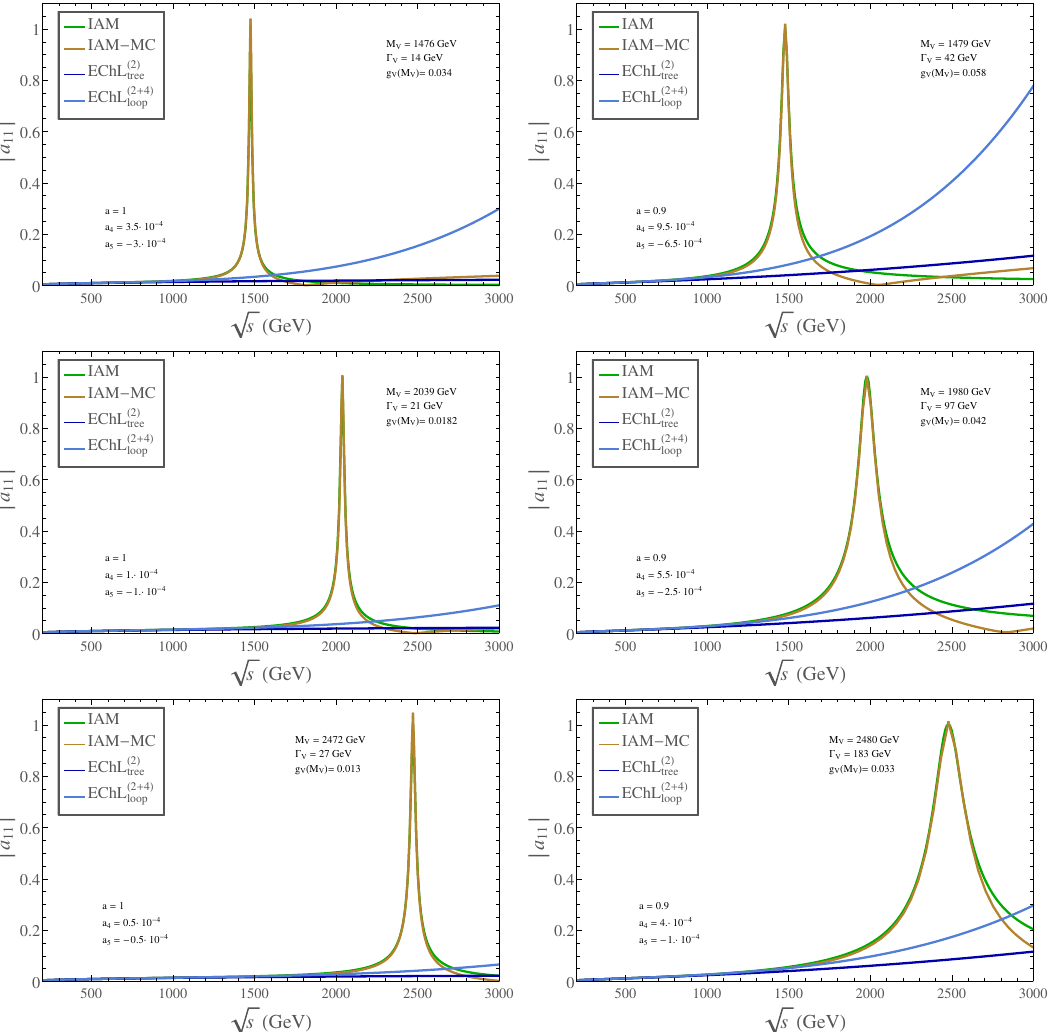
Figure 7 . Predictions of the a 11 partial waves as a function of the center of mass energy p s j j for all the selected benchmark points in table 1. Di(cid:11)erent lines correspond to the di(cid:11)erent models considered in the text: EChL unitarized with the IAM (green), our IAM-MC model (orange), non- unitarized EChL up to ( p 2 ) (dark blue) and non-unitarized EChL up to O contributions (light